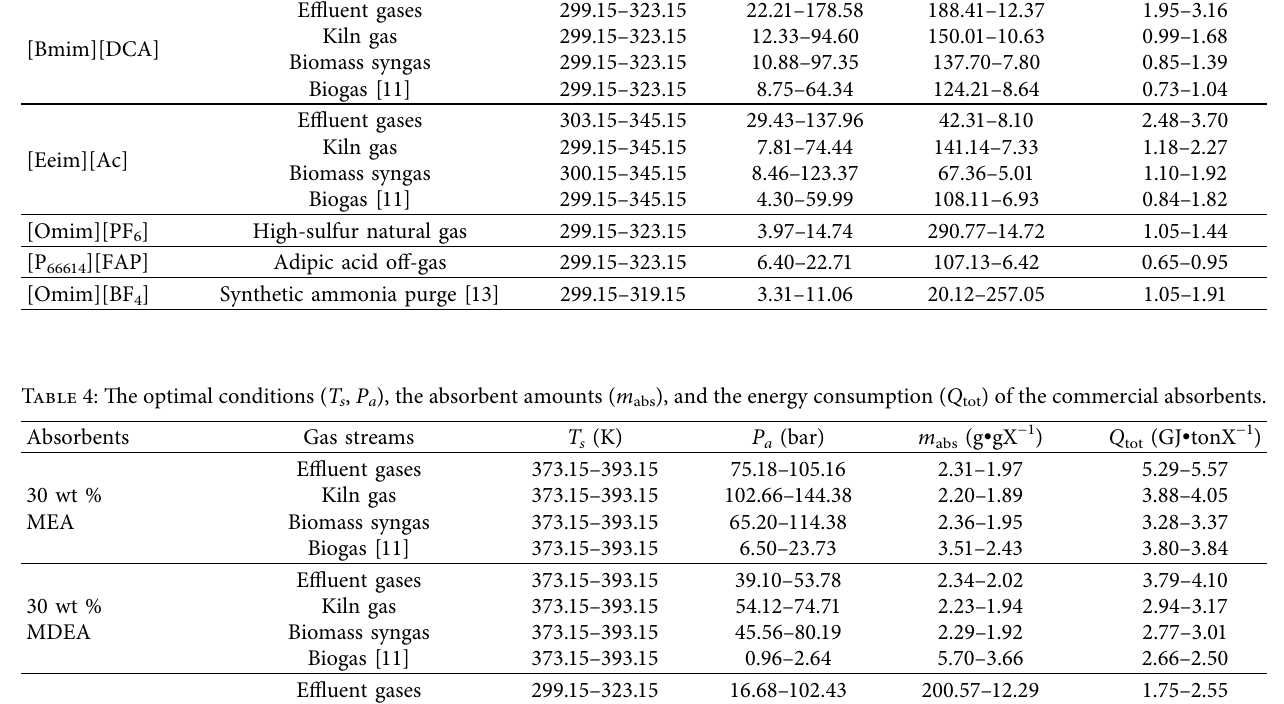
Table 3: Te optimal condition ( T s , P a ), the absorbents amounts ( m abs ), and the energy consumption ( Q tot ) of the screened absorbents. Absorbents CO 2 streams